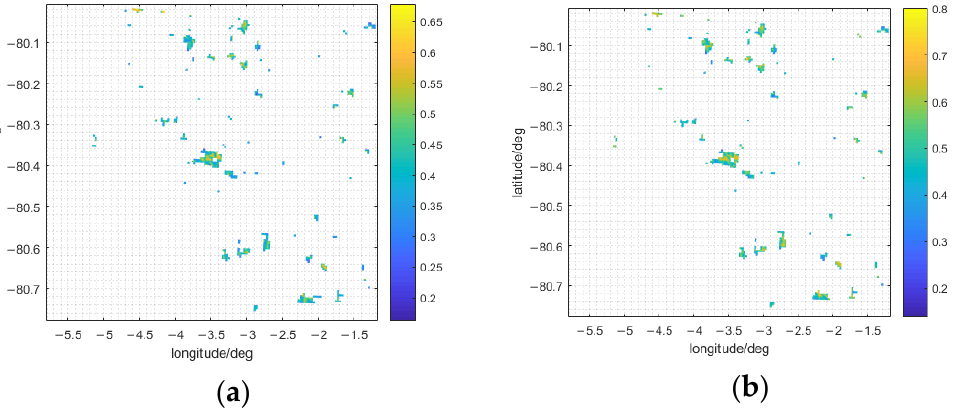
Figure 11. The selected area is Malapert A shows in Figure 10 and corresponding TA is 1 time that of Earth’s radius; the two scenarios are ( a ) maximum tolerable sunlight of 0.2, and ( b ) optimal sunlight 0.1 and maximum tolerable sunlight of 0.2.